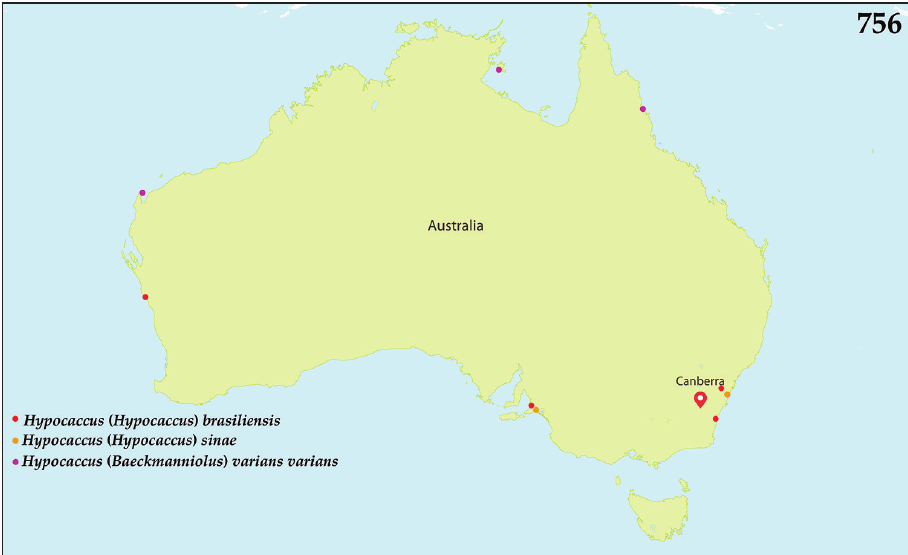
Figure 756. Distribution of Hypocaccus species in Australia: Hypocaccus ( Hypocaccus ) brasiliensis (Paykull, 1811); Hypocaccus ( Hypocaccus ) sinae (Marseul, 1862) and Hypocaccus ( Baeckmanniolus ) varians varians (Schmidt,